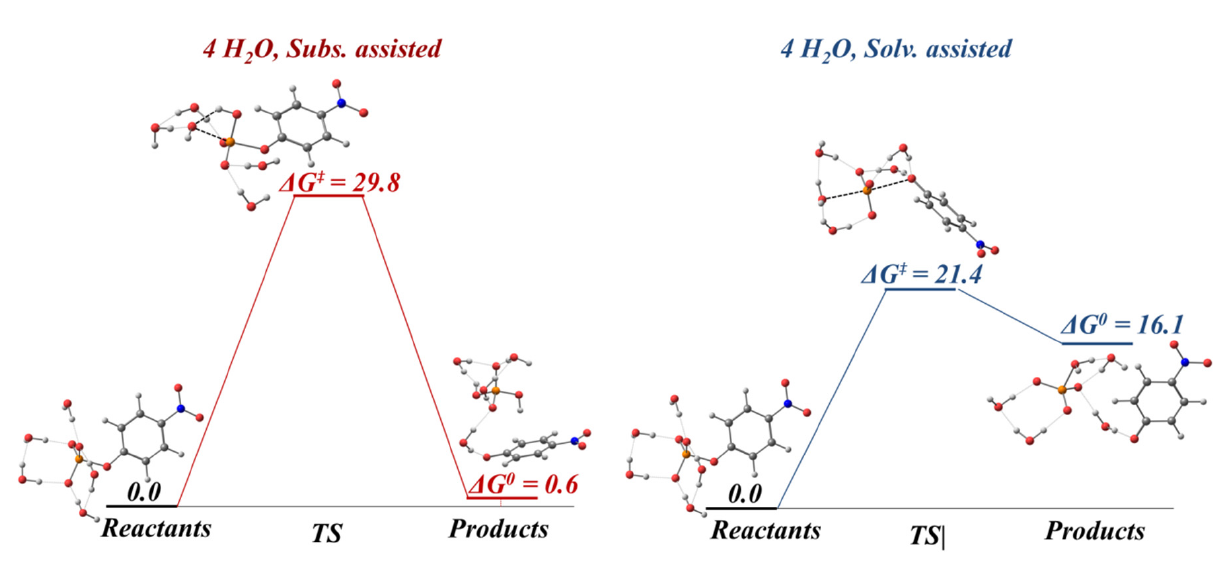
Figure 35. Non-catalyzed reaction mechanisms for the pNPP hydrolysis. Substrate assisted mechanism ( left ) and solvent assisted mechanism ( right ). Gibbs free energies in kcal mol − 1 .